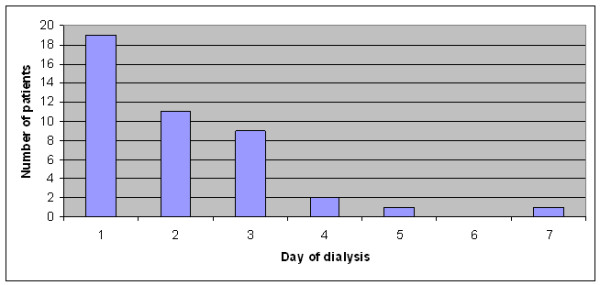
Day of hospital admission that dialysis was commenced.